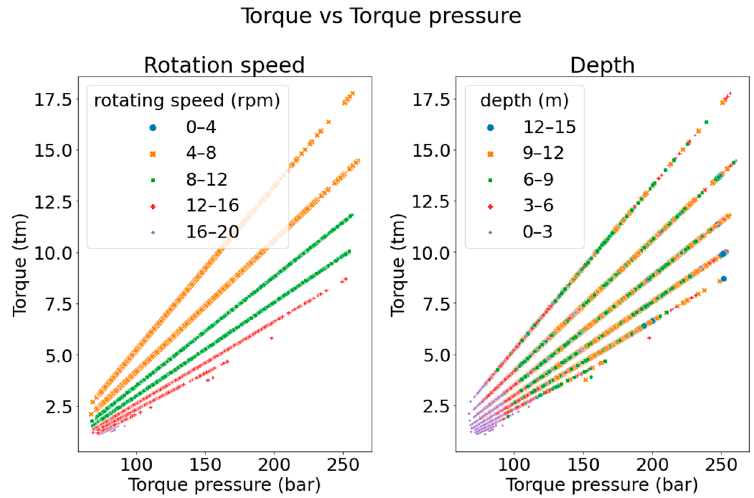
Figure 9. Rotation torque vs torque pressure on site 1 reviewed. To the left depending on the speed of rotation and to the right depending on the depth.